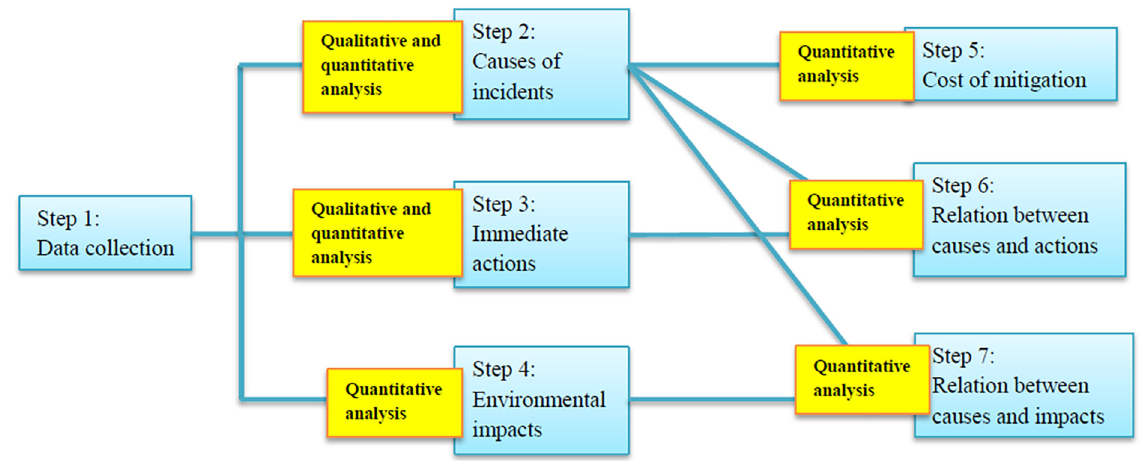
Figure 1. The framework for environmental incident analysis